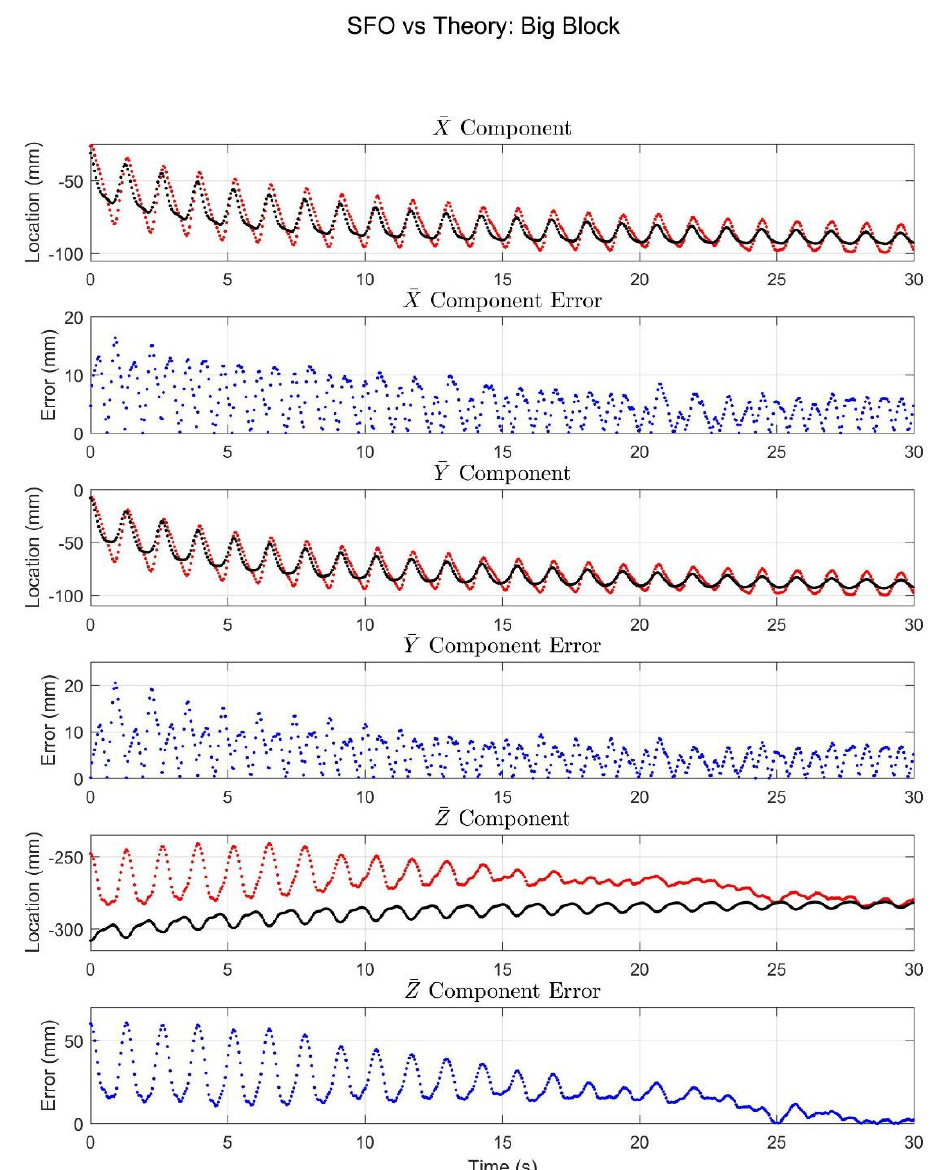
Figure 9. The results for the big block trial. The black and red (or light and dark) plots denote the marker and SFO joint center component solutions, respectively, in terms of 𝑋̅ , 𝑌̅ , and 𝑍̅ components. The error plots show the difference between the two solutions.